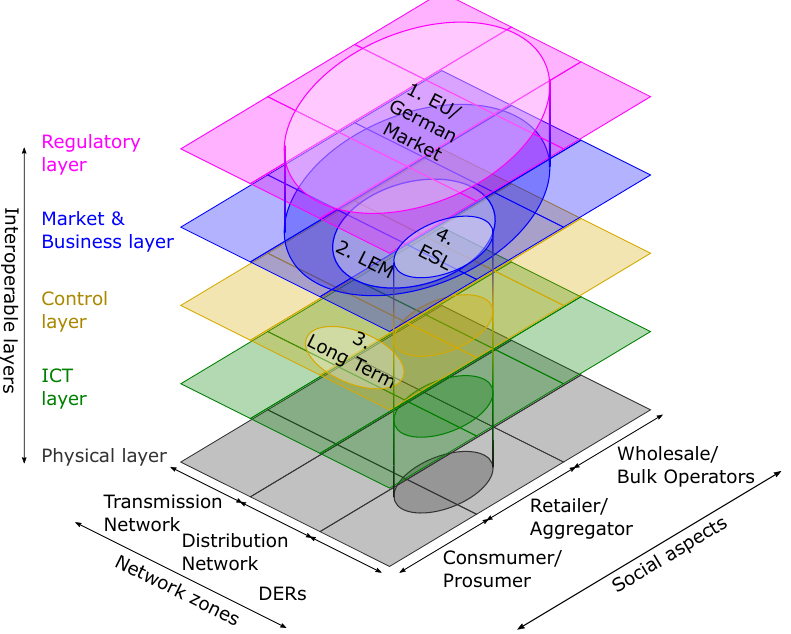
Figure 1. Overview of concept and chapters in accordance with Santodomingo et al. [5]. 1. A model for EU or German market simulation is presented in Section 2. 2. An implementation of a LEM is described in Section 3. 3. A concept for long term operation is given in Section 4. 4. The concept for Energy Signal Light (ESL) is presented in Section